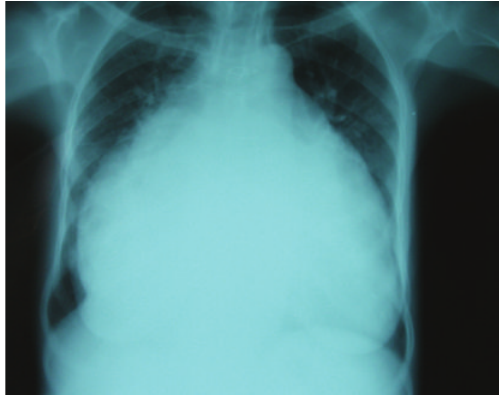
Figure 2: Transthoracic echocardiography, apical four chambers view. Massive enlargement of the right atrium. The right atrial area was 80.6 cm 2 (53.7cm 2 /m 2 ), and the calculated right atrial volume was 621 mL (414mL/m 2 ). LA: left atrium. LV: left ventricle. RA: right atrium. RV: right ventricle.